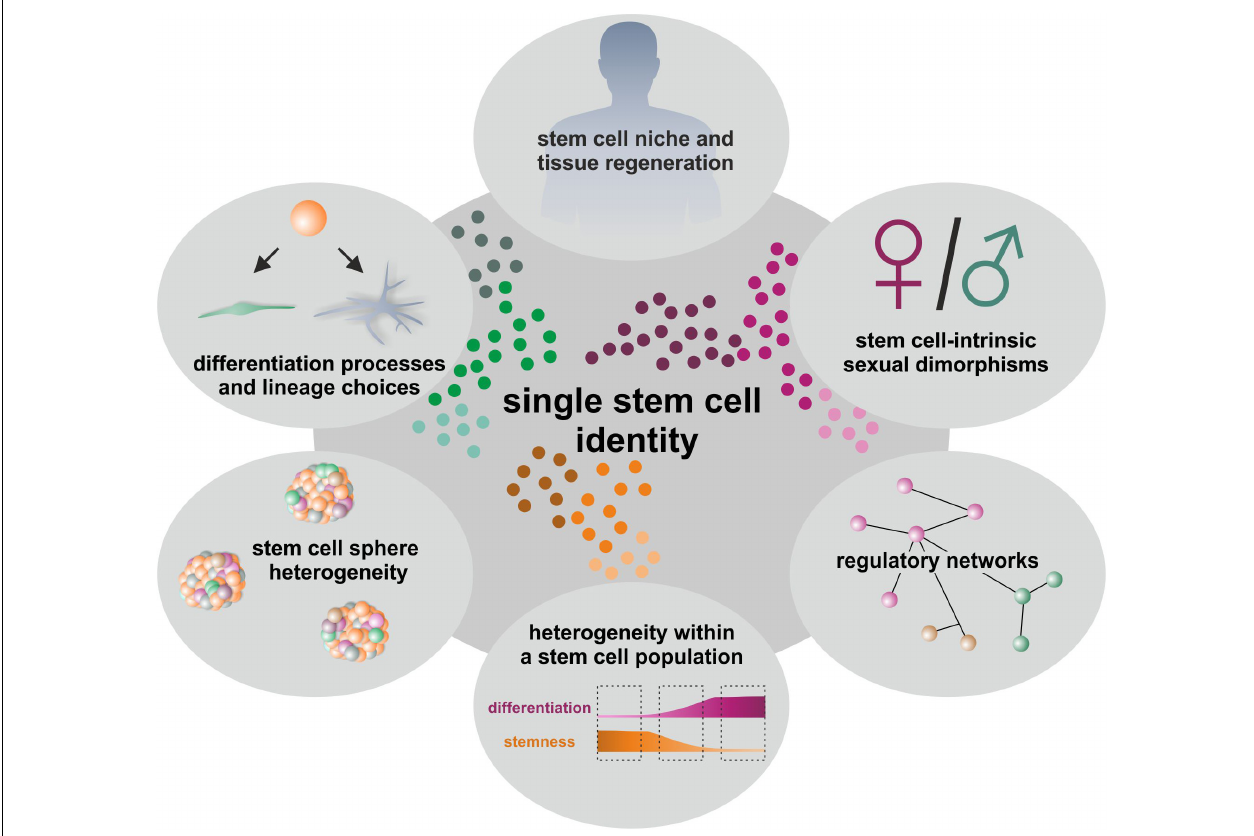
FIGURE 1 | Determination of single stem cell identities gives insights into linage choices, regulatory networks, niches and model systems like cultured stem cell-derived spheroids as well as tissue